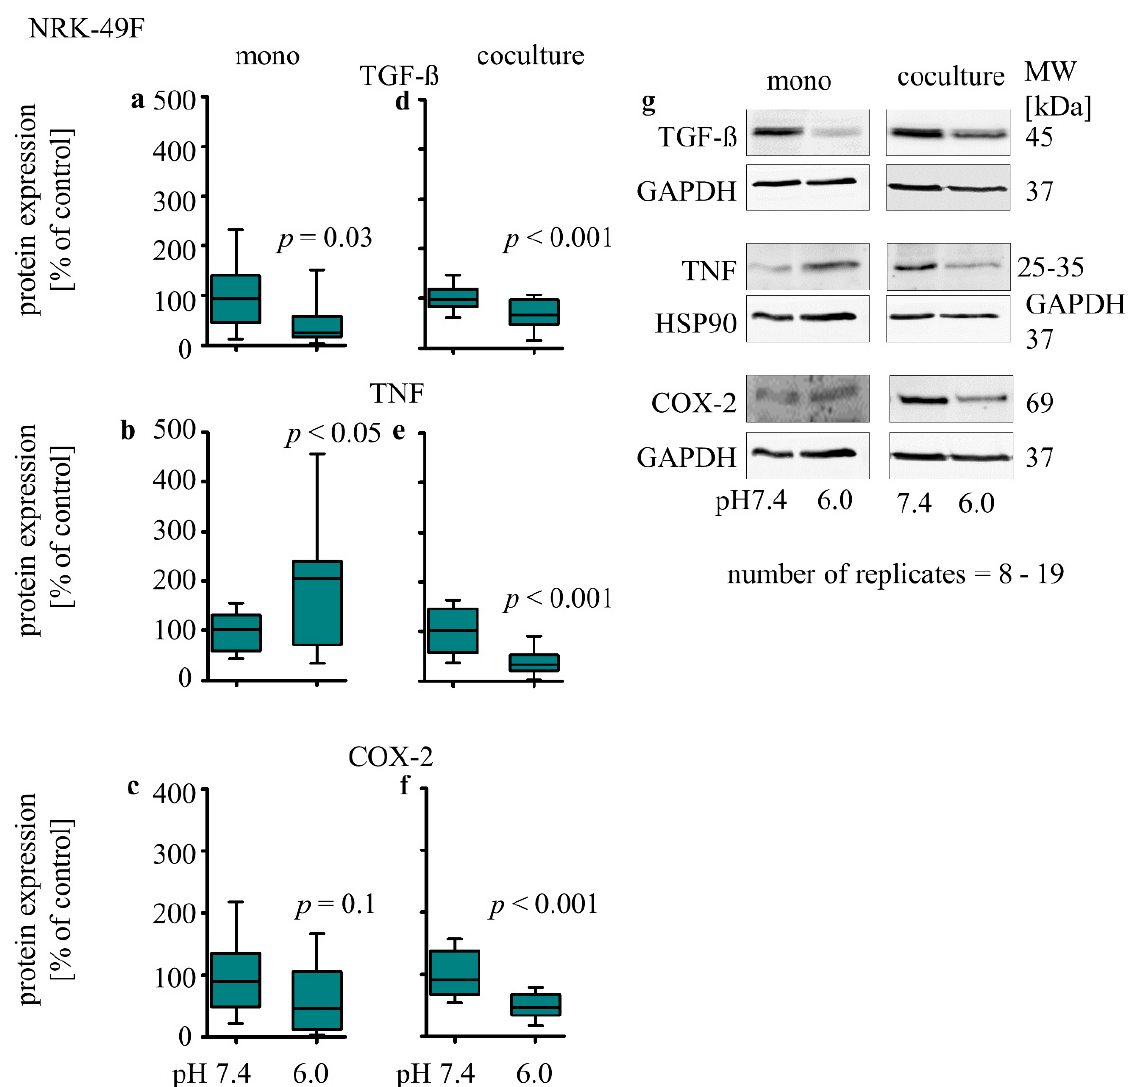
Figure 6. Acidosis effect on inflammation markers in NRK-49F cells in mono- and co-cultures. Impact of acidosis on TGF- β ( a , d ), TNF ( b , e ), COX-2 ( c , f ). Representative Western blots of proteins isolated from cells exposed to acidic media ( g ). p < 0.05 at significant difference compared with the control group; n − (8 − 19). exposure time = 48 h.